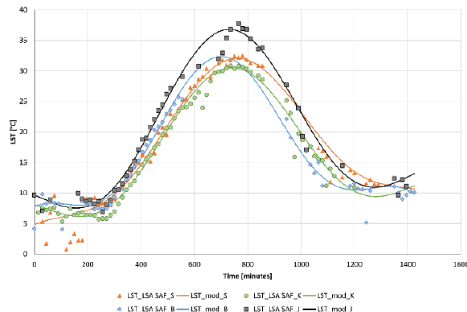
Figure 3. Example of fitted and original LST time series on the Beja (B), Jendouba (J), Siliana (S) and Kef (K) stations for May 6, 2010.